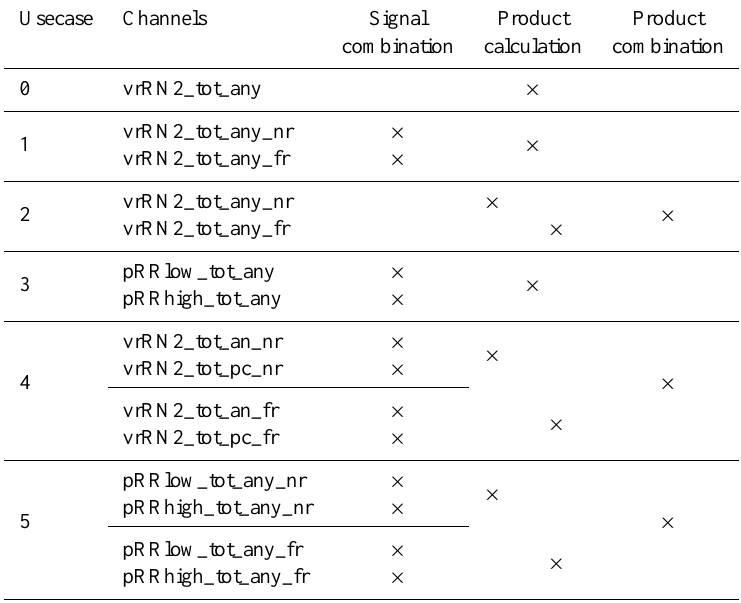
Table A3. SCC usecases implemented for the calculation of the atmospheric particle extinction coefficient profile using the Raman technique. The structure of the table is the same one as in Table